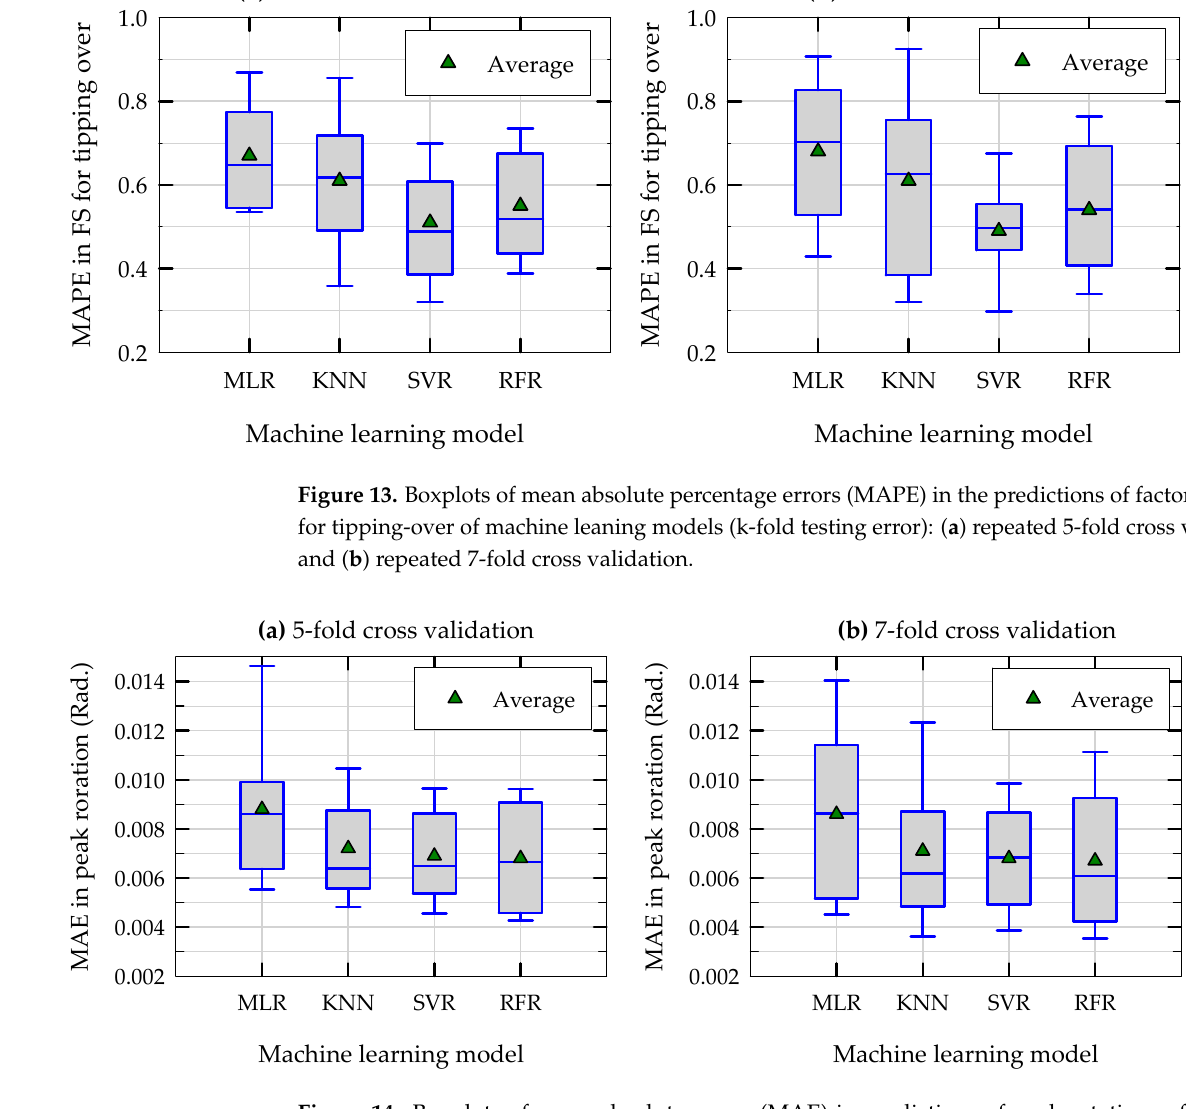
Figure 13. Boxplots of mean absolute percentage errors (MAPE) in the predictions of factor of safety for tipping-over of machine leaning models (k-fold testing error): ( a ) repeated 5-fold cross validation and ( b ) repeated 7-fold cross validation.